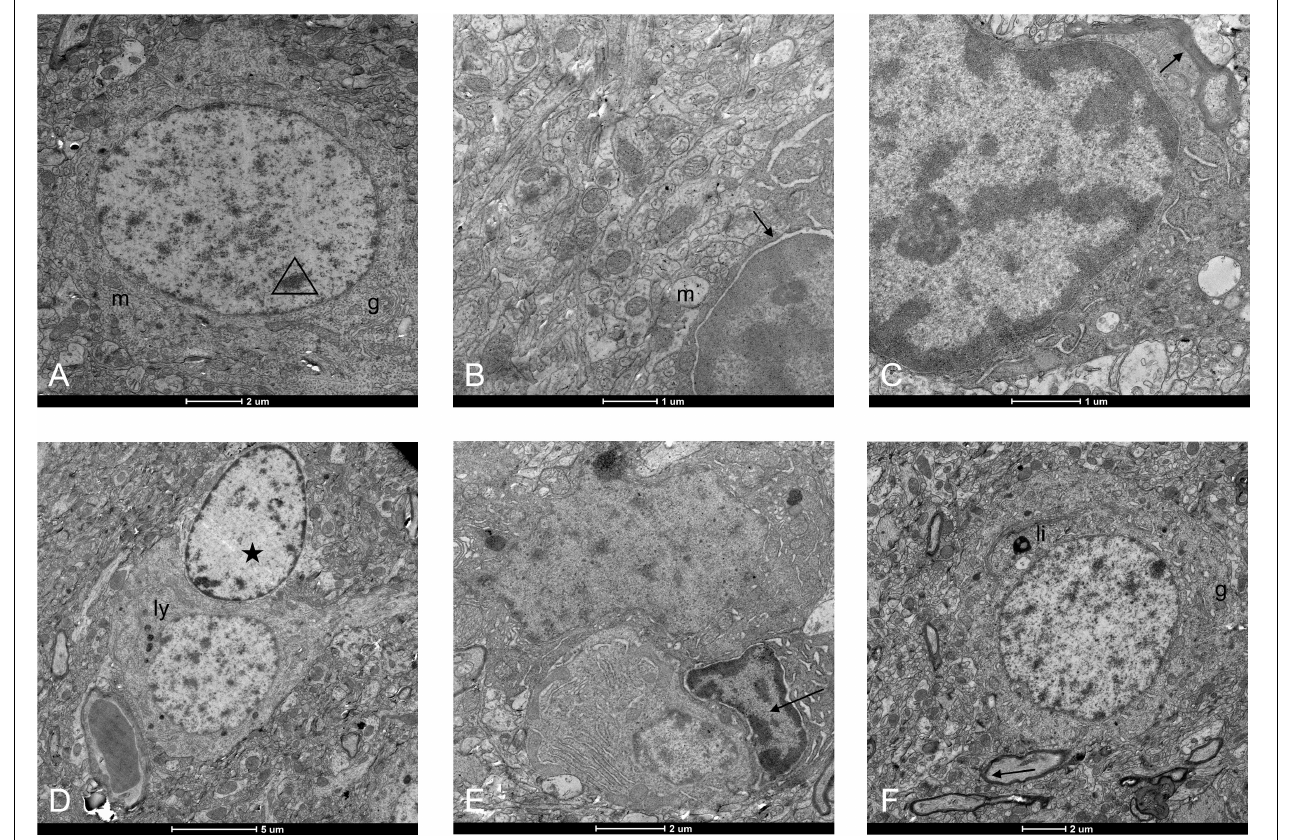
FIGURE 5 | Ultrastructure of neural cells under an electron microscope in the WMI group. (A) Neuronal cell injury initiates programed cell apoptosis, and chromatin in the nucleus begins to condense. Organelles such as mitochondria (“m”)and Golgi apparatus (“g”) are normal. Scale bar = 2 µ m. (B) Nucleolus pyknosis, nuclear membrane, and nucleolar space enlarges (arrow), and mitochondrial swelling. Scale bar = 1 µ m. (C) The oligodendrocyte has a darker cytoplasm than the surroundings and is in attachment to a myelin sheath (arrow). Its nucleus was deformed, and chromatin was highly condensed. Mitochondria appeared vacuolated with excessive swelling, even some floccule appeared in the lumens. Scale bar = 1 µ m. (D) A neuron in contact with the blood vessel was degenerative with more intracytoplasmic lysosomes (“ly”). An astrocyte came to repair it (pentacle). Scale bar = 5 µ m. (E) The microglia (arrow) phagocytized a neural cell and a plasma cell. The specific cell morphology of the nerve cell above disappeared, but the plasma cell below was still visible with relatively intact cell morphology, and there was also abundant Golgi in the cytoplasm. Scale bar = 2 µ m. (F) Lipofuscin (“li”) appeared within the cytoplasm of an injured neuron and there was some stunted myelin in the periphery. Myelin damage (arrow). Scale bar = 2 µ